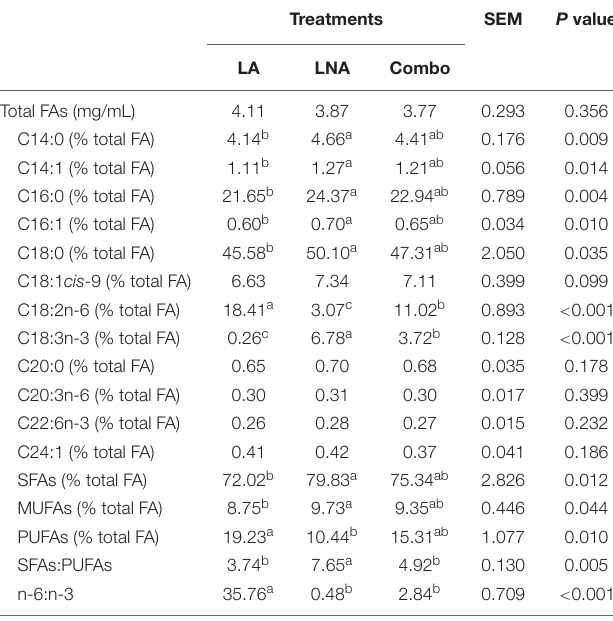
TABLE 2 | Effects of fatty acid supplementation on the fatty acid profiles of rumen buffer just before incubation.